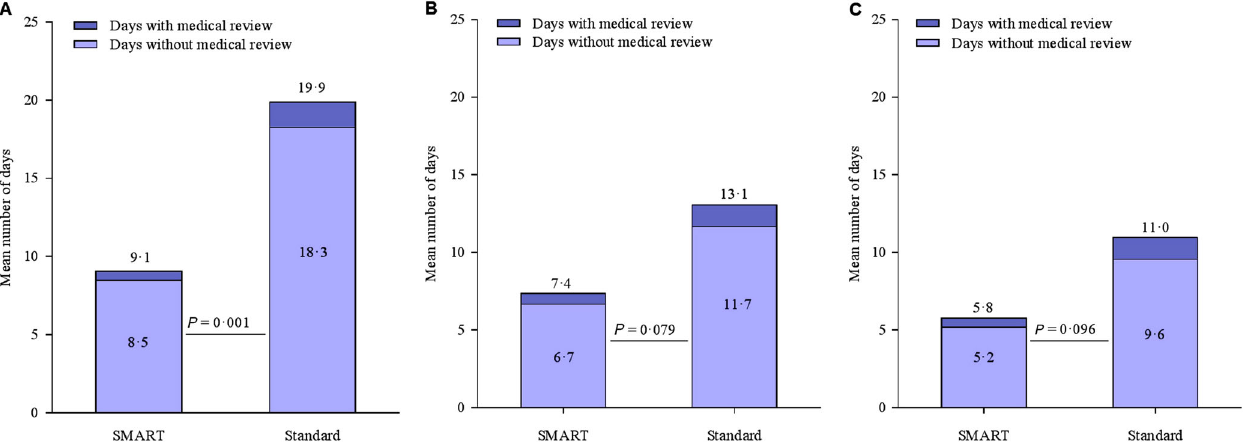
Fig. 1 a Mean number of high use days in participants with at least one high use episode, and mean number of high use days without medical review within 48 h in participants with at least one high use episode. b Mean number of marked overuse days in participants with at least one marked overuse episode, and mean number of marked overuse days without medical review within 48 h in participants with at least one marked overuse episode. c Mean number of extreme overuse days in participants with at least one extreme overuse episode, and mean number of extreme overuse days without medical review within 48 h in participants with at least one extreme overuse